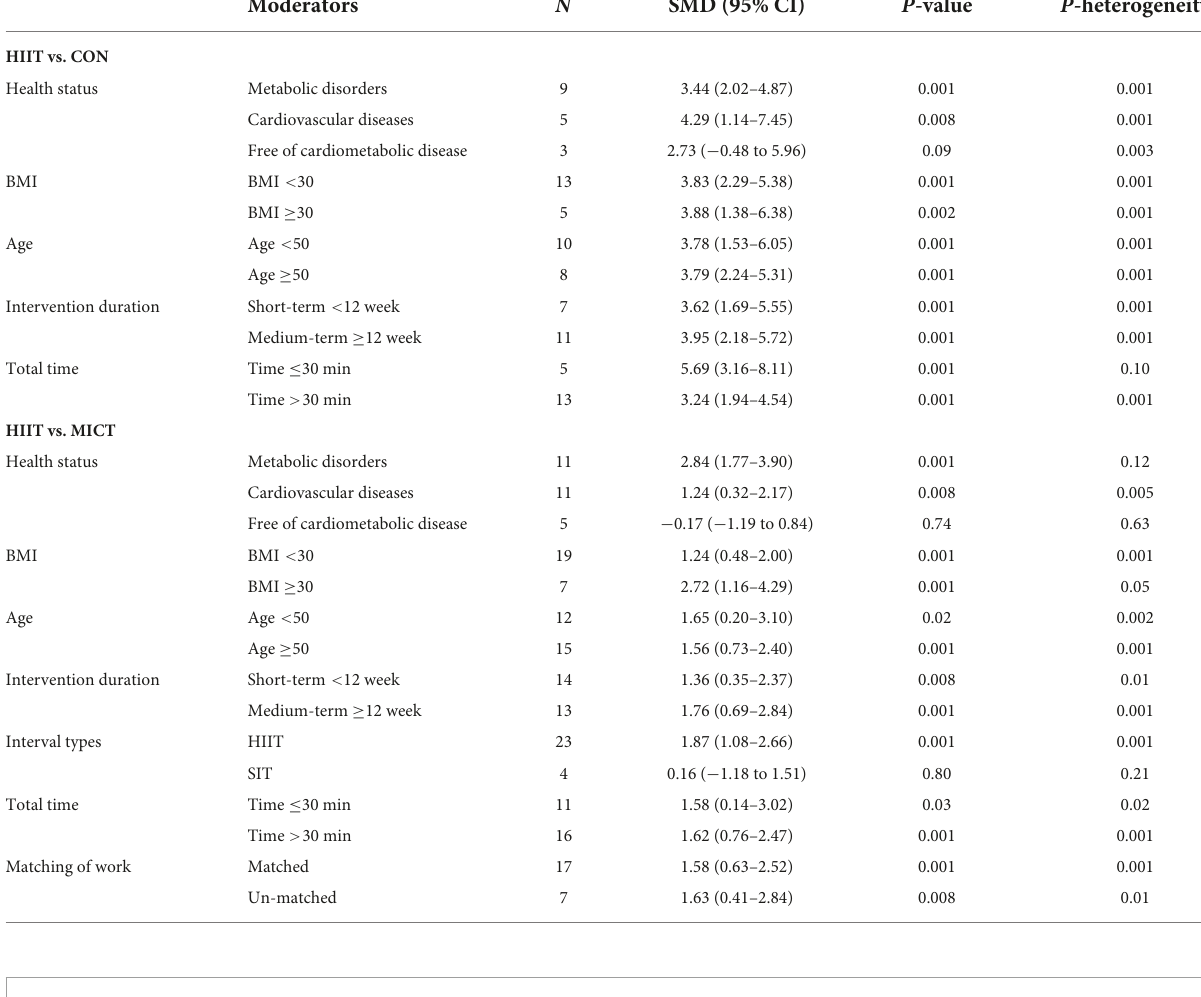
TABLE 2 Summary of subgroup analyses for the effects of HIIT vs. CON and MICT on FMD.